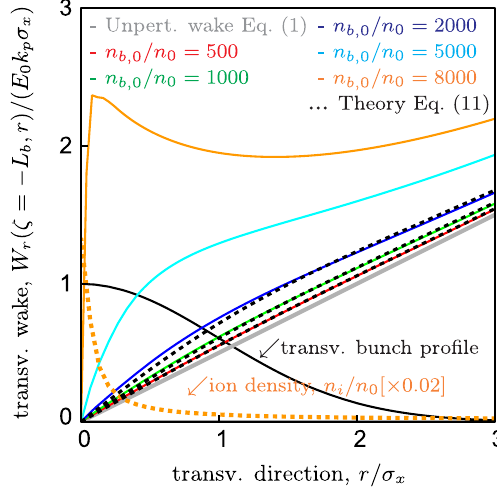
obtained r . Colored lines b =n 0 ¼ 8000 for n b b; 0